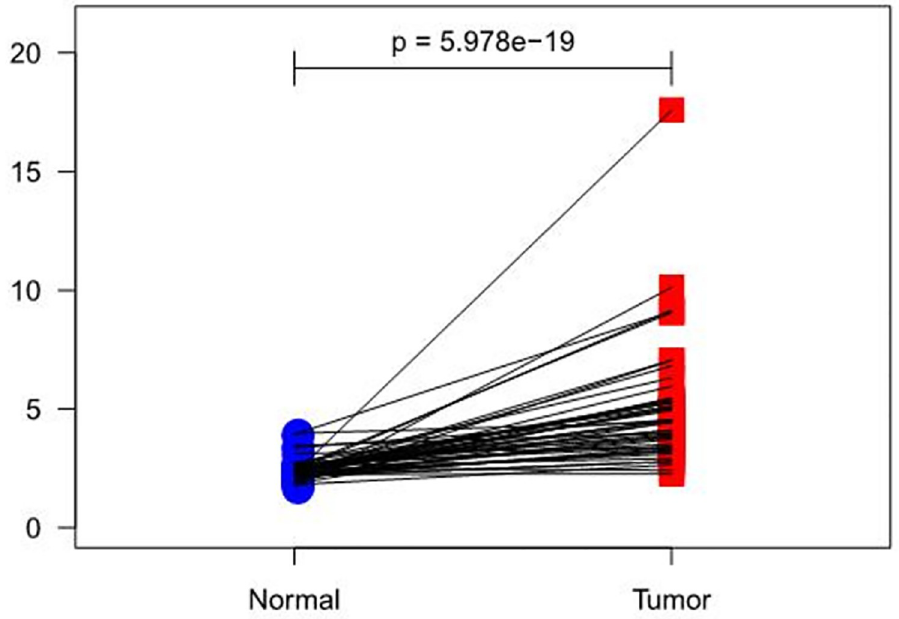
Fig 7. A paired scatter plot of RIOX2 gene differential expression between cancerous tissue and adjacent normal tissue in lung squamous cell carcinoma. The abscissa represents the sample group and the ordinate represents the RIOX2 gene expression level. The red represents the cancer tissue sample group and the blue represents the normal sample group.